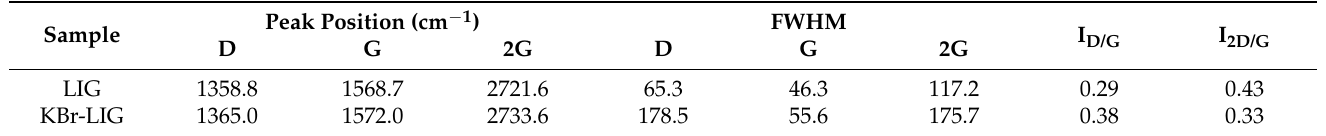
Table 1. The peak position, FWHM, and ratios of D to G and 2D to G peaks express the defect- and layer-induced graphene.